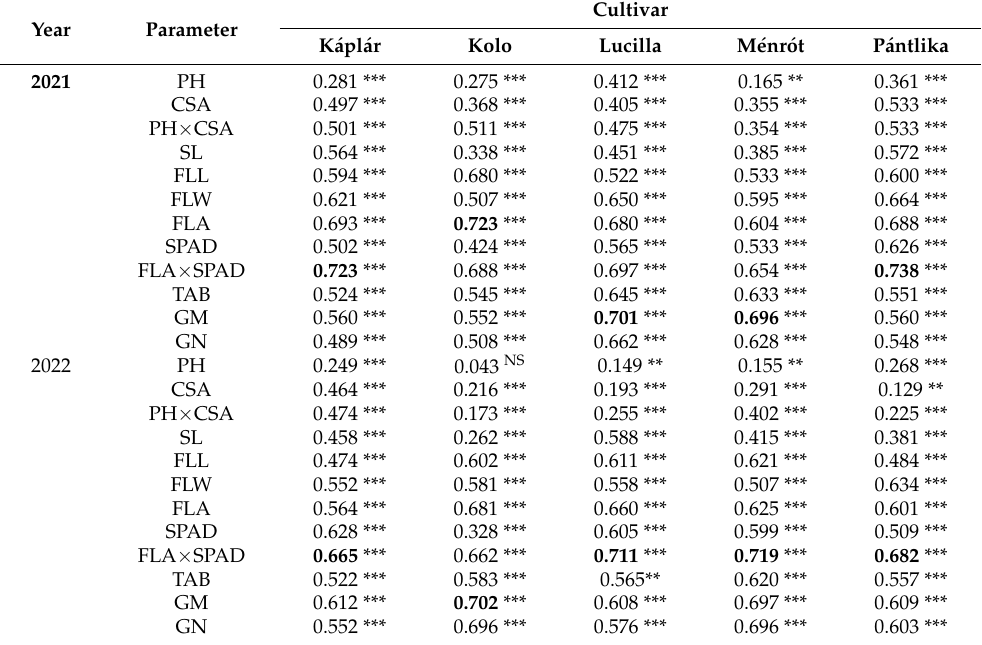
Table 1. Coefficient of determination (R 2 ) values and significance levels (based on the F test) for linear regressions between the saturation root electrical capacitance (C R *) and various plant parameters investigated in five wheat cultivars in two years. The regressions were established for the individual plants (n = 60). The highest R 2 for a given cultivar and year is written in bold. For abbreviations, see Figure 2. ** p < 0.01; *** p < 0.001; NS not significant.